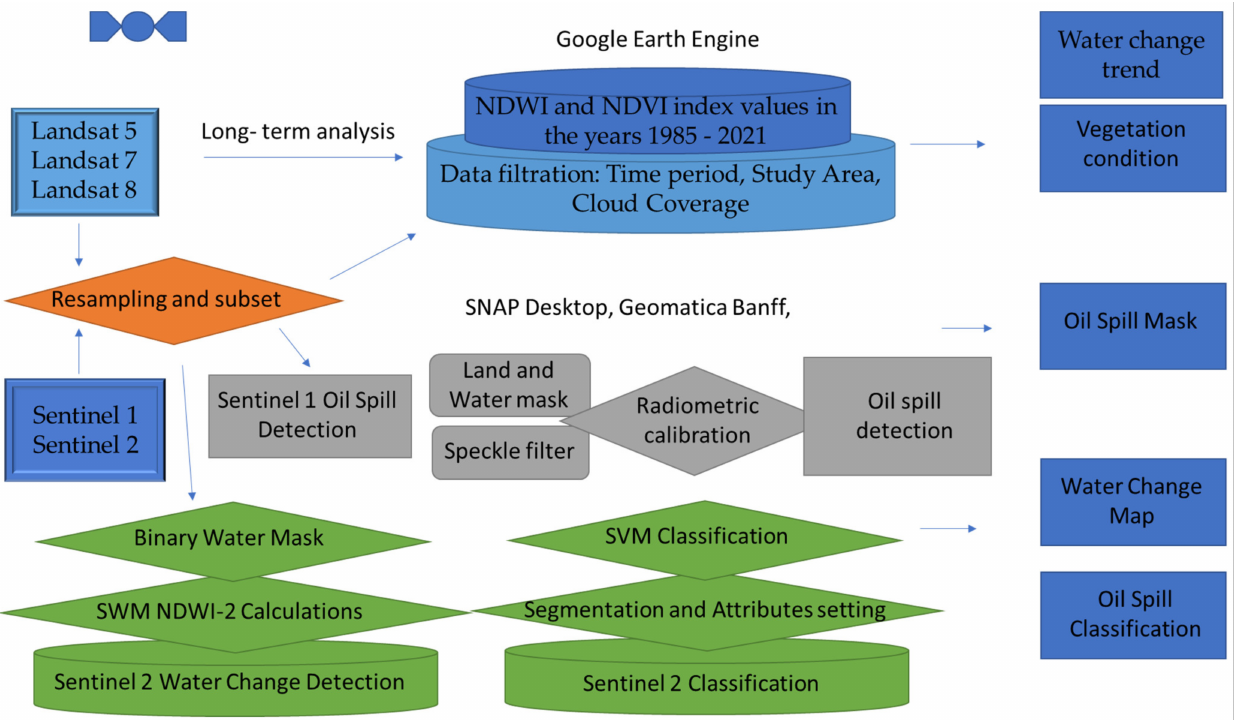
Figure 2. Data processing